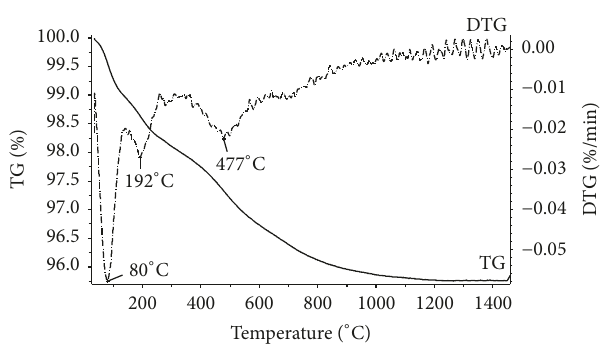
Figure 1: Thermogravimetric analysis of the investigated powders suspension in silica sol (gelled under NH 4 Cl solution). 154.5 mg of sample was heated in the air with heating rate 3.5 ∘